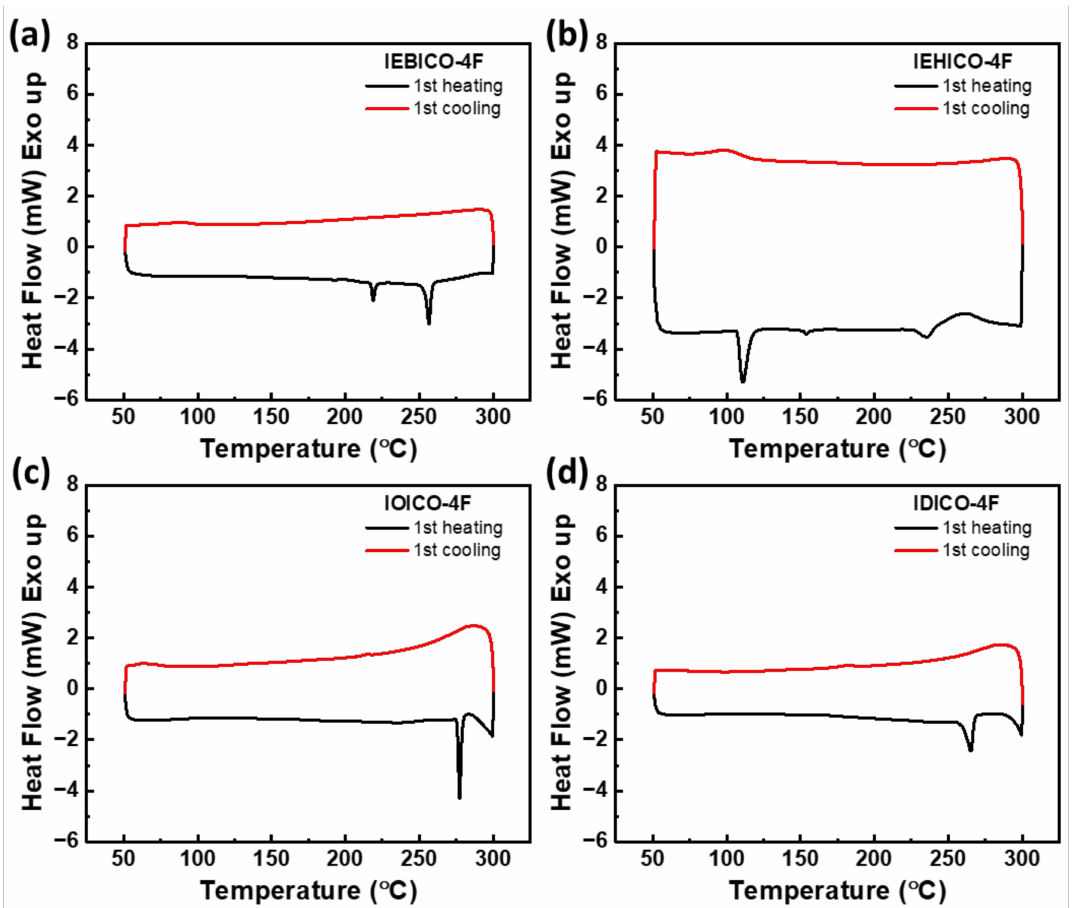
Figure 2. Differential scanning calorimetry curves of NFAs: ( a ) IEBICO-4F, ( b ) IEHICO-4F, ( c ) IOICO-4F, and ( d )